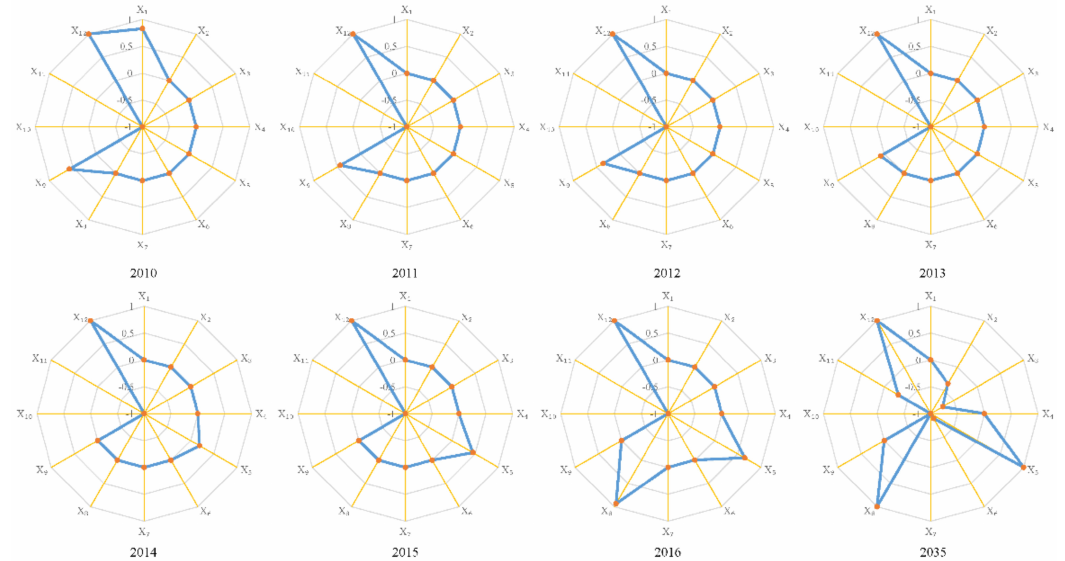
Figure 7. Subtraction set pair potential of each index in the current years and in the planning